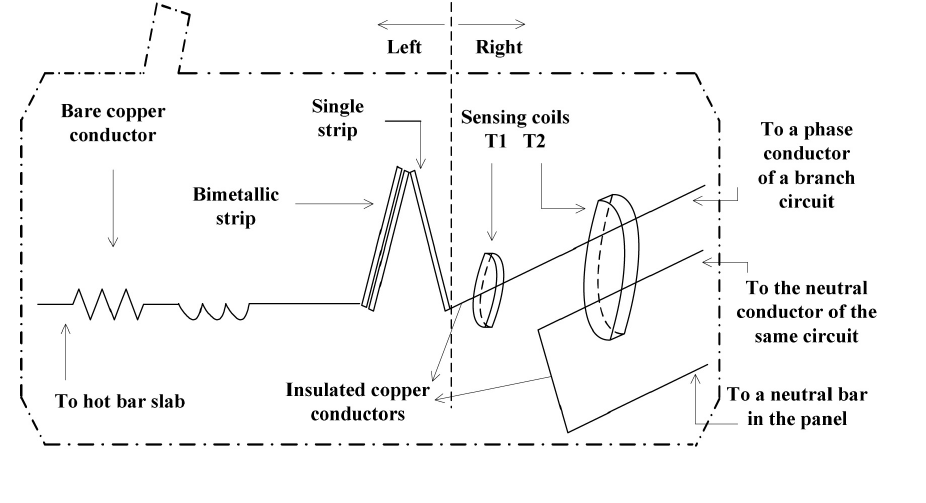
Figure 5. The circuit breaker